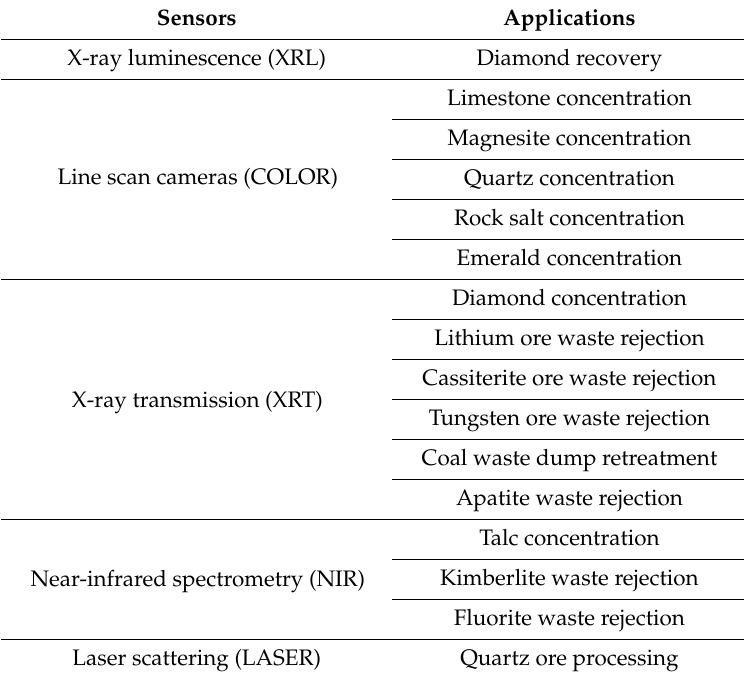
Table 5. Possible applications of main